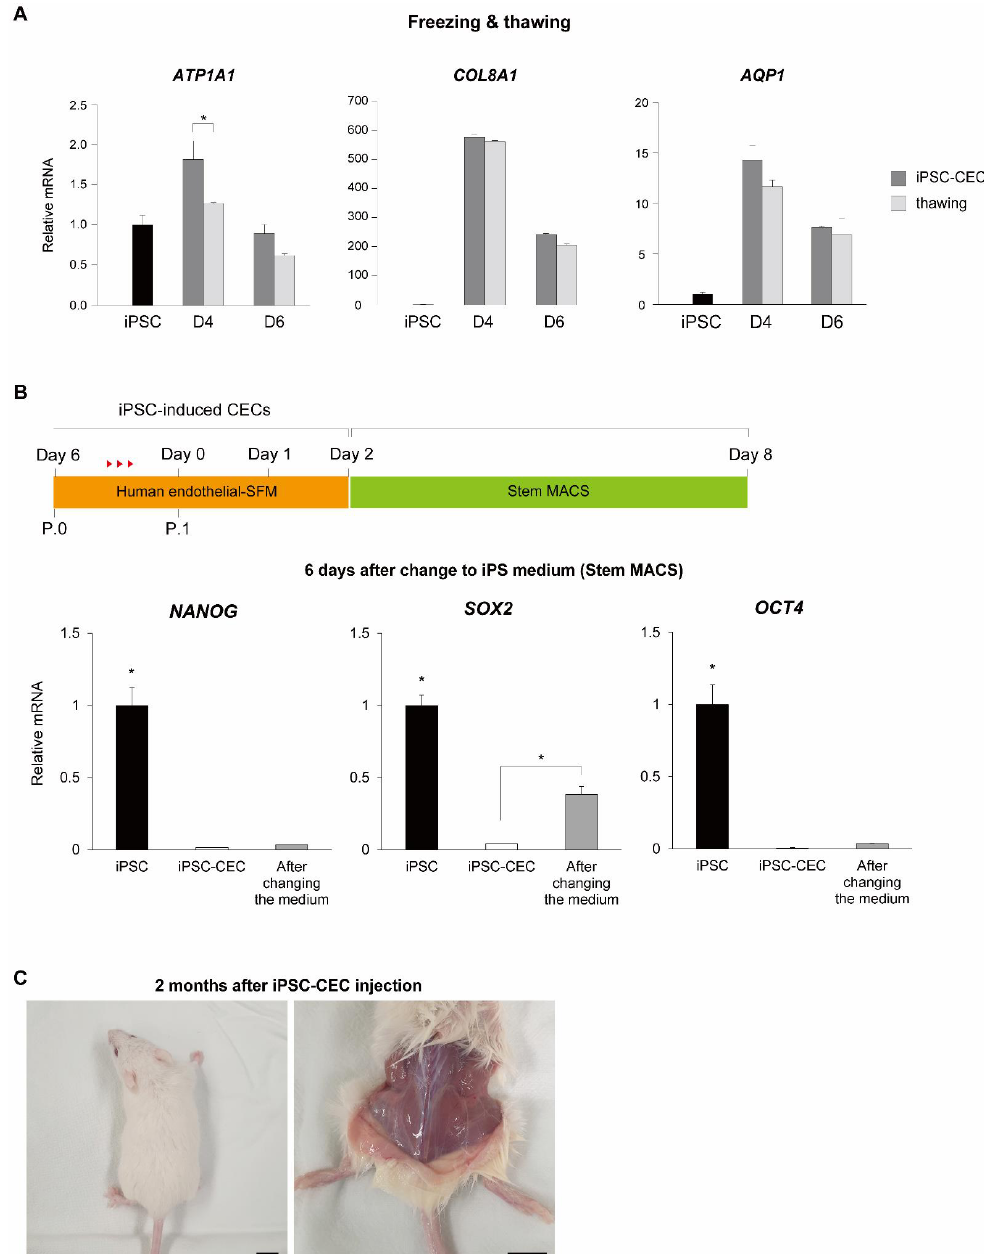
Figure 3. Stability of iPSC-derived CECs. ( A ) qRT-PCR analysis measuring ATP1A1 , COL8A1 , and AQP1 expression relative to that of GAPDH, following freezing and thawing of iPSC-derived CECs. Expression of all three genes was maintained after freezing and thawing (* p < 0.05). ( B ) Experimental scheme for replacing CEC culture medium with iPSC culture medium;